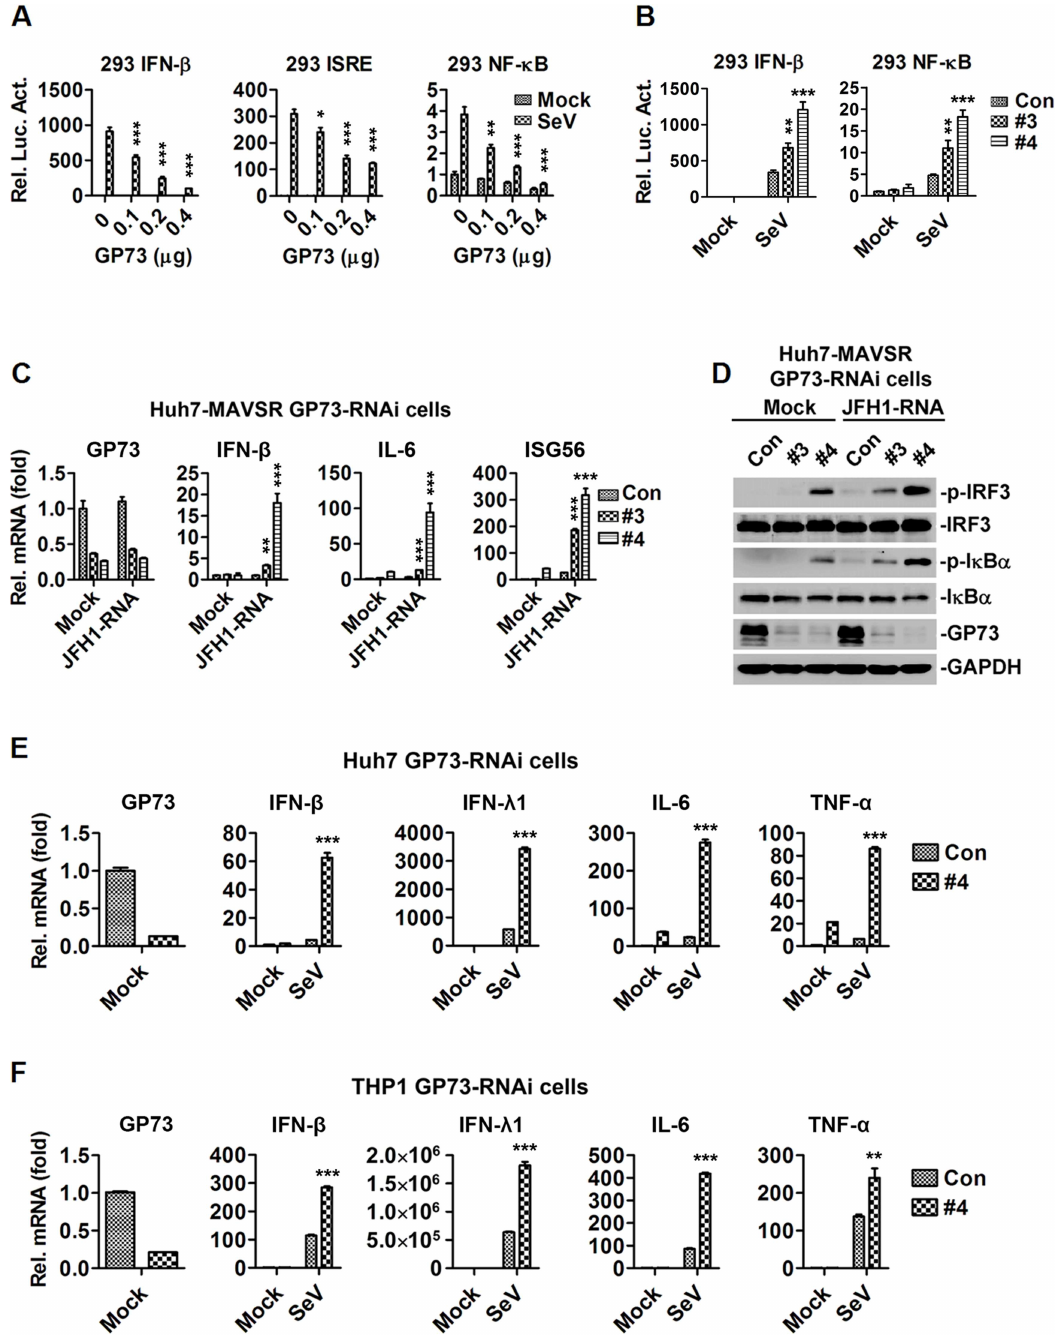
Fig 2. GP73 represses host innate immunity during viral infection. ( A ) HEK293 cells (1 × 10 5 ) were transfected with the IFN- β , ISRE or NF- κ B reporters(0.1 μ g) and GP73 expressingplasmidat indicatedconcentrations for 24 h, and infected with SeV for 10 h before luciferasereporter assays were performed. ( B ) HEK293cells (1 × 10 5 ) were transfected with IFN- β or NF- κ B reporter (0.05 μ g) and GP73 -shRNAs expressingplasmids(1 μ g) for 48 h, and infected with SeV for 10 h before reporter assays were performed. ( C , D ) GP73 -shRNAs transduced stable Huh7-MAVSR cells were transfected with in vitro transcribedJFH1 genomicRNA for 16 h. IFN- β , IL-6 and ISG56 mRNAs were quantifiedby RT-PCR (C) and p-IRF3 and p-I κ B α were detected by WB (D). ( E , F ) GP73 -shRNAs transducedstable Huh7 ( E ) and THP-1 ( F ) cells were infected with SeV for 12 h. IFN- β , IFN- λ l , IL-6 and TNF- α mNRAs were quantifiedby RT-PCR. Bar graphsrepresent means ± SD, * P < 0.05, ** P < 0.01, *** P < 0.001, comparedwith control group.